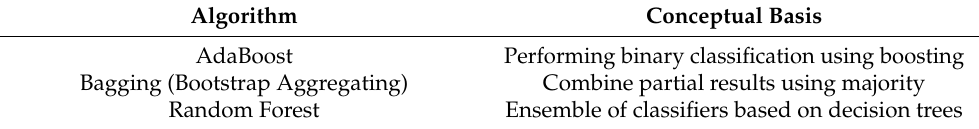
Table 5. Classifier ensemble algorithms against which the LA-SVD classifier will be